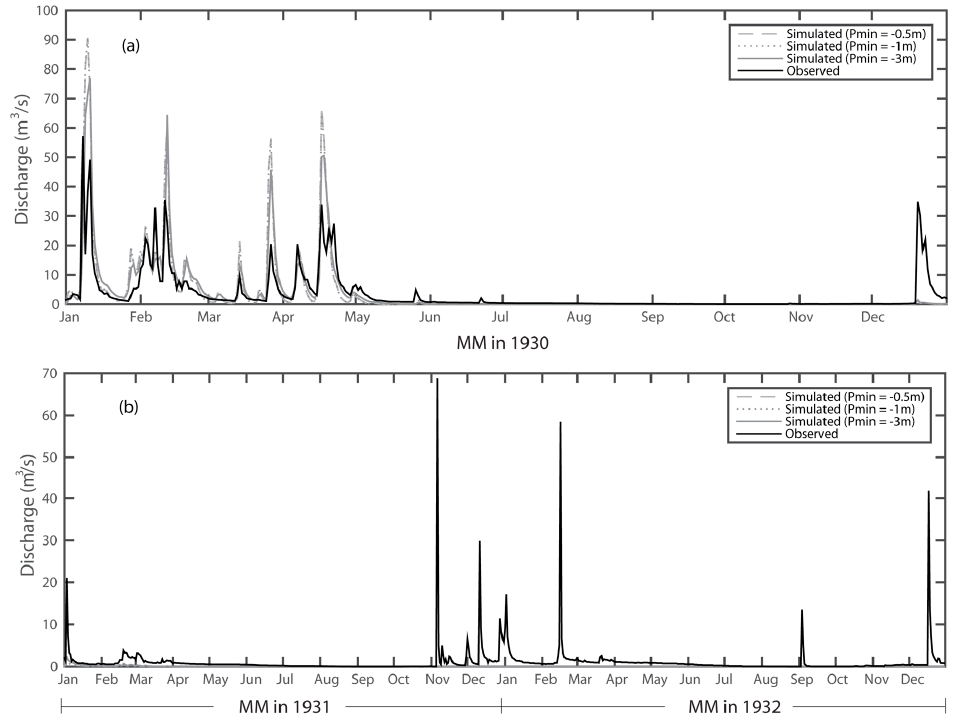
Figure 7. Simulations for the CATHY model applied to the Rio Mannu catchment for the ( a ) 1930 period (calibration period for tRIBS) and ( b ) 1931–1932 (validation period for tRIBS) using a member of the 50 ensemble simulations. Simulations are carried out increasing the threshold level of moisture deficit in terms of preassure head P min from the value transferred from tRIBS (P min = − 3 m) to P min = − 1 m and P min = − 0.5 m.